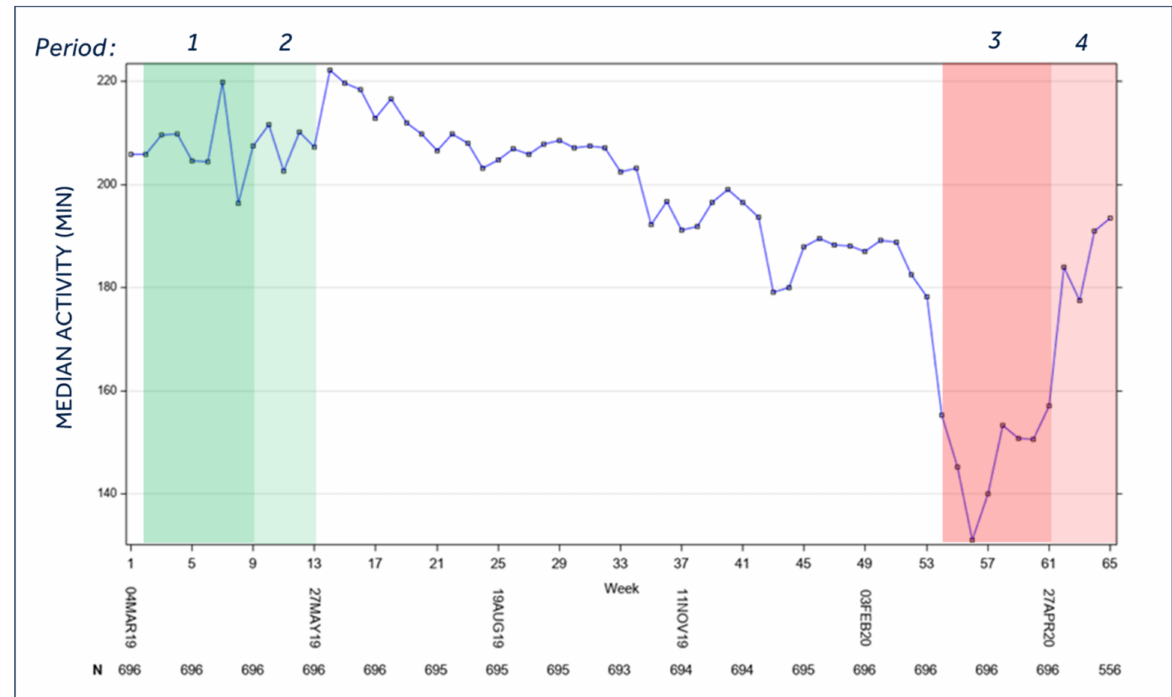
Figure 1. Median activity of the entire population during the study period. Legend: Period 1 = Lockdown control period (year 2019); Period 2 = Post-lockdown control period (year 2019); Period 3 = Lockdown period (year 2020); Period 4 = Post- lockdown period (year 2020). For the temporal definition of the three periods, please see the Methods section; p < 0.0001 for mean period 3 vs. mean period 1 , mean period 3 vs. mean period 4 , mean period 2 vs. mean period 4 ; p = 0.0162 mean period 1 vs. mean period 2